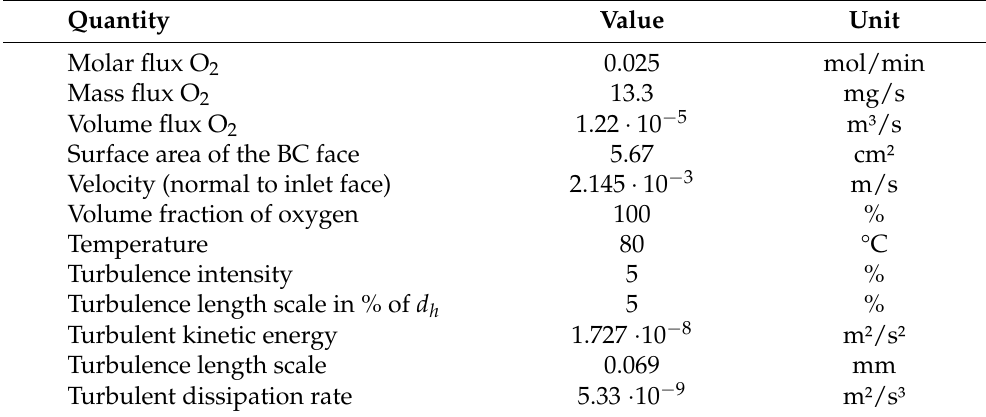
Table 5. Oxygen source boundary condition